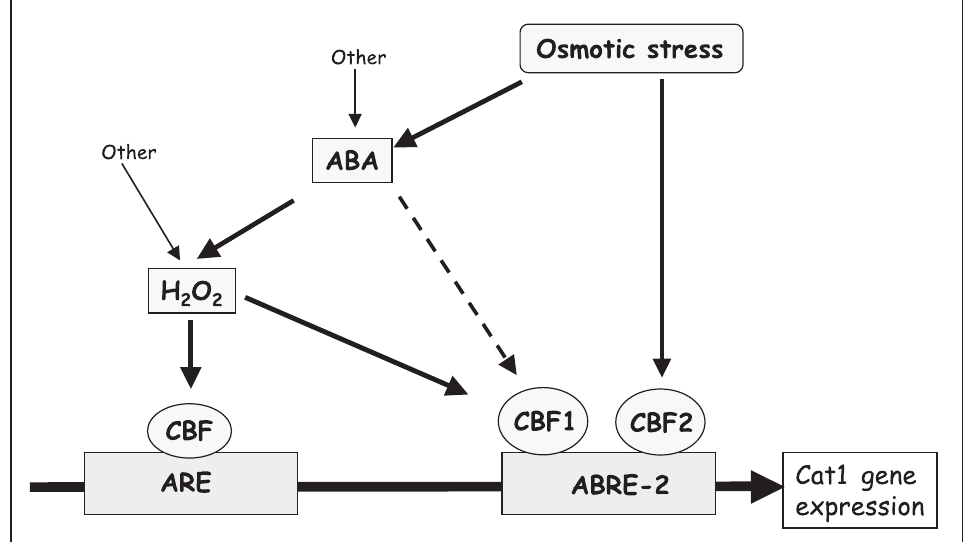
Figure 10. Schematic represen- tation of the possible signal transduction pathways of Cat1 gene expression in response to the plant hormone abscisic acid (ABA) and osmotic stress in maize. ARE = antioxidant-re- sponsive element; ABRE-2 = ABA responsive element 2; CBF1 = Cat1 binding factor-1; CBF2 = Cat1 binding